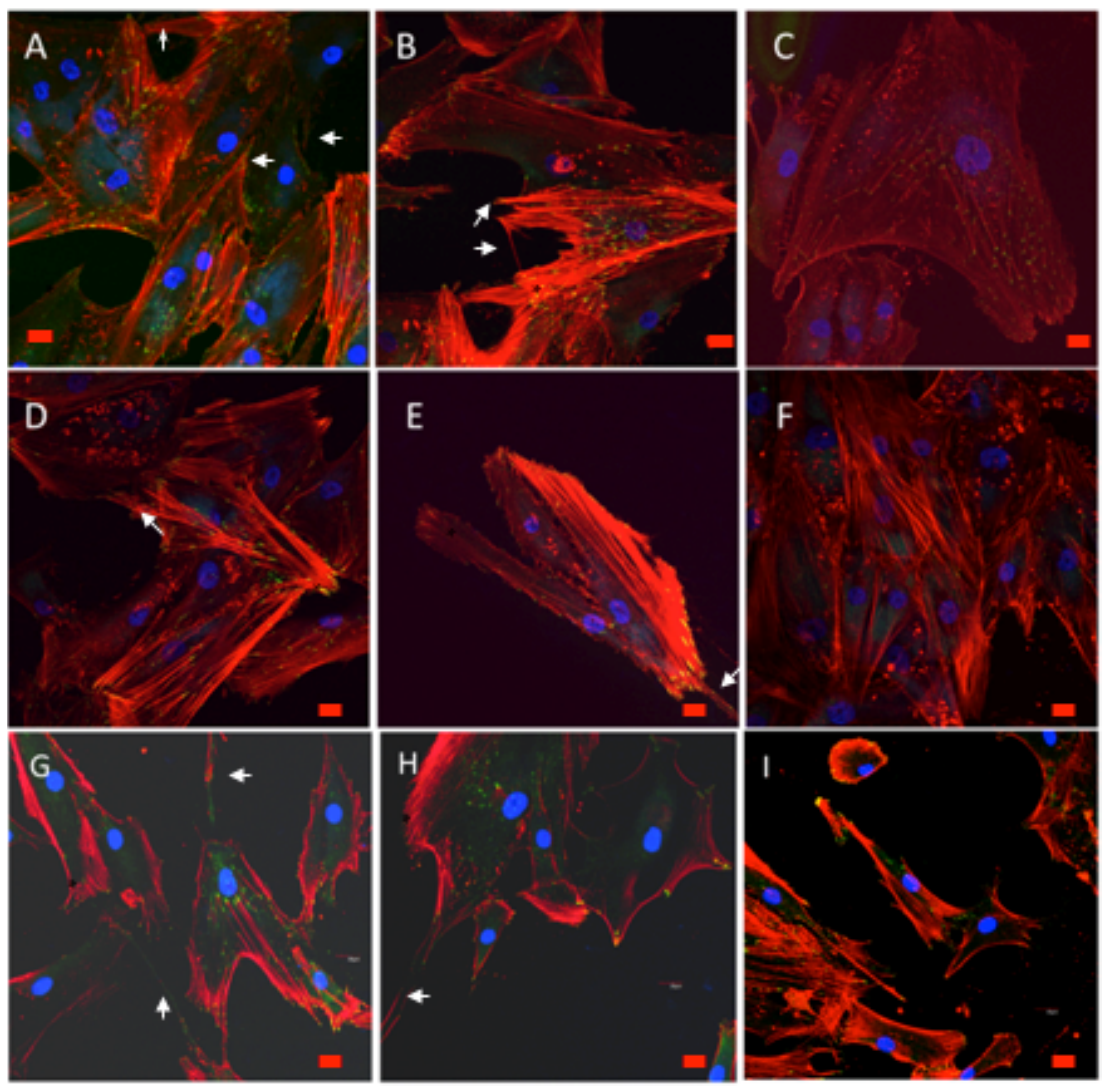
Figure 9. HOB ® osteoblasts grown on CS7G2 sample after 48 h ( A , B ), 72 h ( D , E ) and 1 week ( G , H ) in culture, and examined with confocal microscope (40x objective lens). Osteoblasts grown on glass were used as reference control, shown in ( C ), for 48 h in culture, ( F ) after 72 h in culture and ( I ) after 1 week. In red, rhodamine–phalloidin immunolabelled actin cytoskeletal fibers, showing polarization to material and actin cytoskeletal arrangement into stress fibers. Focal adhesions (yellow) were immunolabelled with antivinculin antibody. Nuclei (blue) were DAPI labelled. Arrow marks filopodial emissions, star marks lamellipodia. Scale bar represents 20 µm.